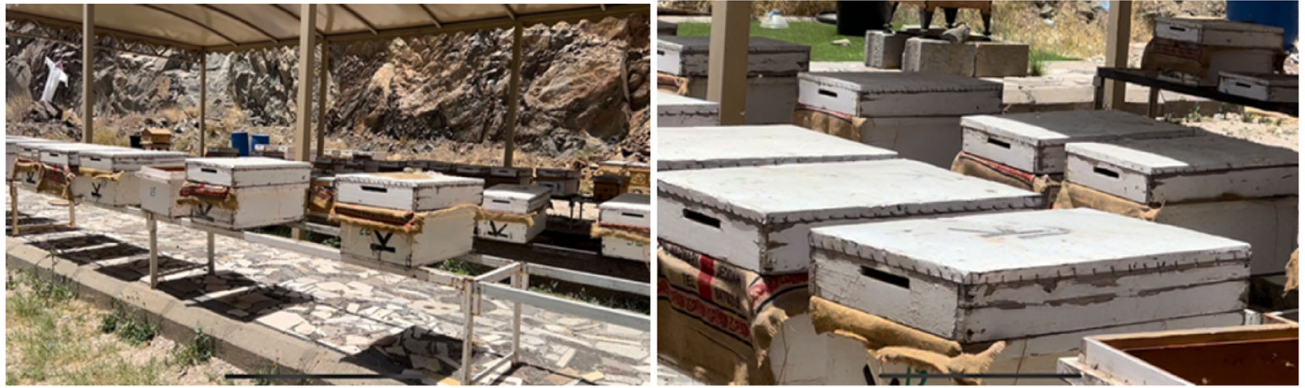
Figure 1. A. mellifera jemenitica apiary set ‐ up.